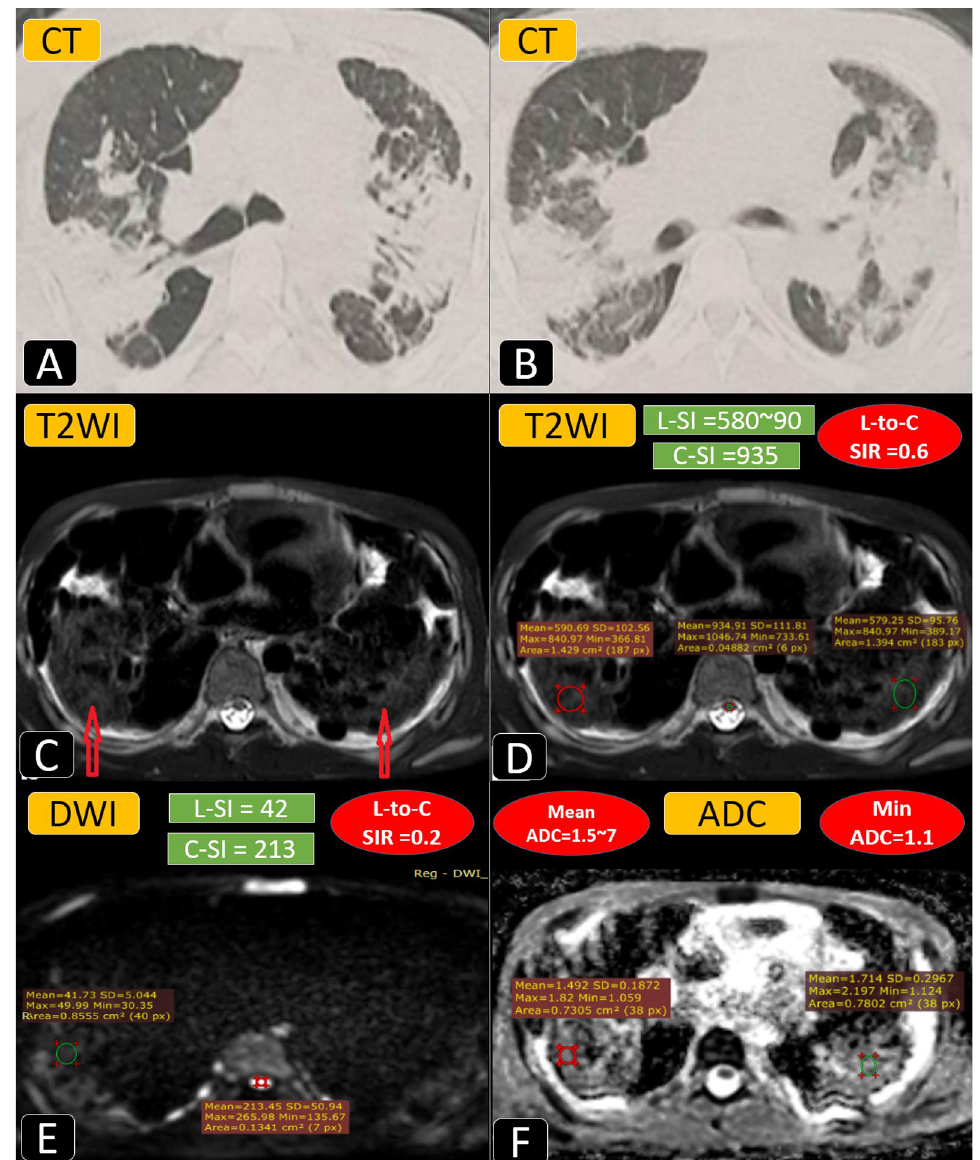
Fig. 7 A 22-year-old male patient with occupational history correlated with the glass industry complained of chronic cough. A, B Axial chest CT cuts (lung window) showed bilateral peri-hilar and peripheral sub-pleural large consolidative mass-like lesions without smooth air bronchogram. C, D Axial T2WI showing the low signal intensity of the bilateral large confluent lesions. After placing two ROIs within the largest lesion and the spinal cord, the lesion-to-spinal cord signal intensity ratio was calculated 0.6. E Axial DWI showing low signal intensity denoting non-restricted = diffusion and lesion-to-spinal cord signal intensity ratio was calculated 0.2. F ADC mapping images showing low signal intensity with minimum = ADC (1.1 10 − 3 mm 2 /s) and mean ADC (1.5–1.7 10 − 3 mm 2 /s). Referring to the estimated cutoff values, T2WI L-to-SC SI ratio, DWI L-to-SC SI ratio, × × minimum ADC, and mean ADC suggested a benign process. Pathologically proven progressive massive fibrosis sequel to pneumoconiosis. PET/CT result was